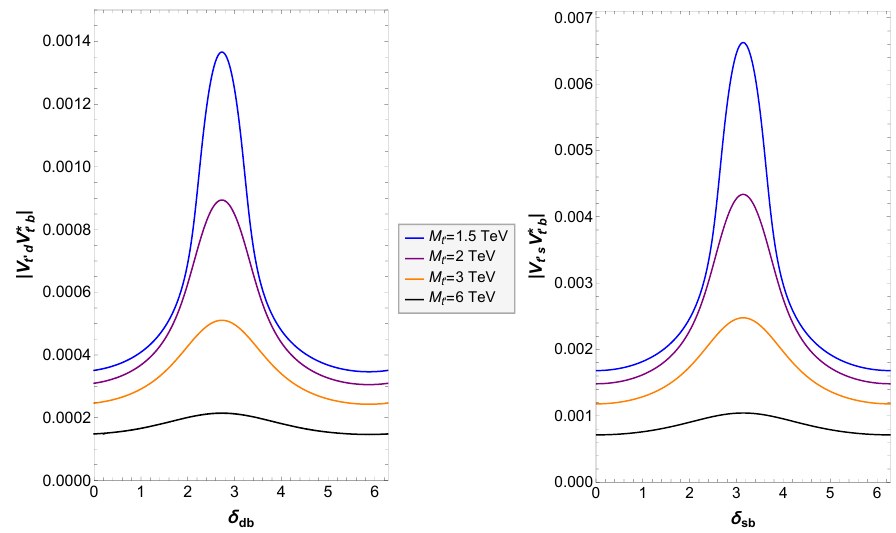
Figure 15 . Upper limits on the products of the mixing elements | V ∗ B-mesons mixing, obtained from the constraint in eqs. eqs. (5.30) with ∆ B of the relative phases δ db = arg( V ∗ masses M t 0 = 1 . 5 , 2 , 3 , 6 TeV (blue, purple, orange and black curves